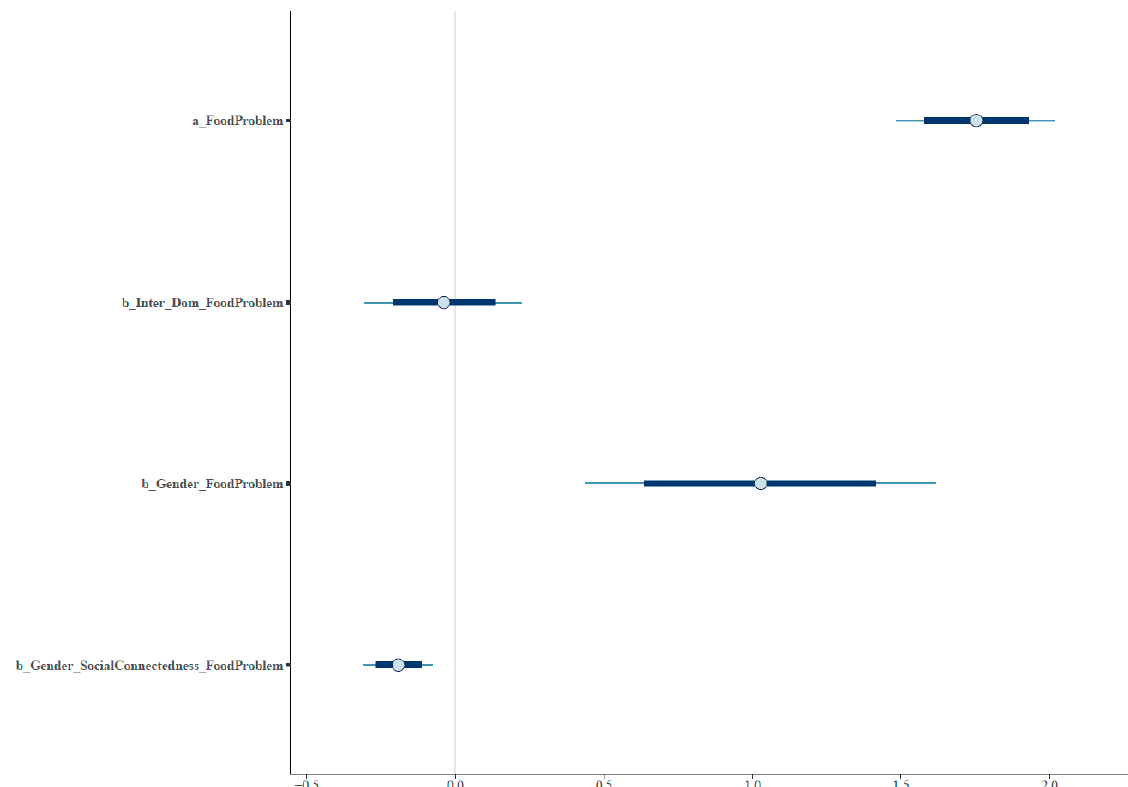
Figure 5. Autocorrelation plots for the model ′ s posterior coefficients. Regarding gender, females were found to be positively associated with a higher level of perceived difficulties in adjusting to new food ( 𝜇 (cid:3008)(cid:3032)(cid:3041)(cid:3031)(cid:3032)(cid:3045) = 1.03 and 𝜎 (cid:3008)(cid:3032)(cid:3041)(cid:3031)(cid:3032)(cid:3045) = 0.30). How- ever, the interaction with social connectedness produced a negative value, suggesting so- cial connectedness lessens the effect of gender on food problems ( 𝜇 (cid:3008)(cid:3032)(cid:3041)(cid:3031)(cid:3032)(cid:3045)_(cid:3020)(cid:3042)(cid:3030)(cid:3036)(cid:3028)(cid:3039)(cid:3004)(cid:3042)(cid:3041)(cid:3041)(cid:3032)(cid:3030)(cid:3047)(cid:3032)(cid:3031)(cid:3041)(cid:3032)(cid:3046)(cid:3046) = − 0.19 and 𝜎 (cid:3008)(cid:3032)(cid:3041)(cid:3031)(cid:3032)(cid:3045)_(cid:3020)(cid:3042)(cid:3030)(cid:3036)(cid:3028)(cid:3039)(cid:3004)(cid:3042)(cid:3041)(cid:3041)(cid:3032)(cid:3030)(cid:3047)(cid:3032)(cid:3031)(cid:3041)(cid:3032)(cid:3046)(cid:3046) = 0.06). The impact of the type of student (domestic or international student) was found to be not significant toward food acculturative prob- lems ( 𝜇 (cid:3010)(cid:3041)(cid:3047)(cid:3032)(cid:3045)_(cid:3005)(cid:3042)(cid:3040) = -0.04 and 𝜎 (cid:3010)(cid:3041)(cid:3047)(cid:3032)(cid:3045)_(cid:3005)(cid:3042)(cid:3040) = 0.13). The posterior distributions of Gender and Gender_SocialConnectedness fell entirely on the positive and negative, respectively, indicat- ing the high reliability of the results (see Figure 6). We can also see that the majority of simulated samples are located on the positive side for Gender ( x -axis) and the negative side for Gender_SocialConnectedness ( y -axis) in the pairwise distribution graph (see Figure 7). We can also confirm the result’s reliability through the demonstration of the 95% high- est posterior density intervals (HPDIs), as shown in Figure 8.